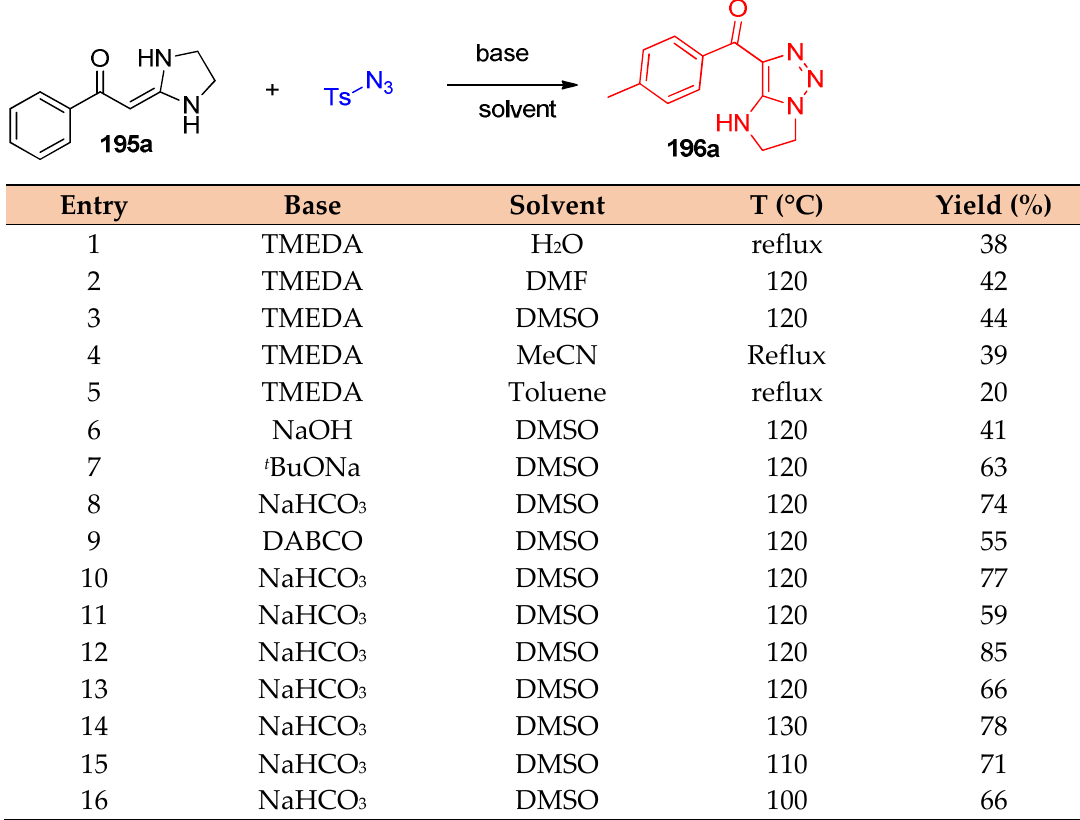
Scheme 72. Screening of the optimized reaction conditions for the reaction of enaminones and tosyl